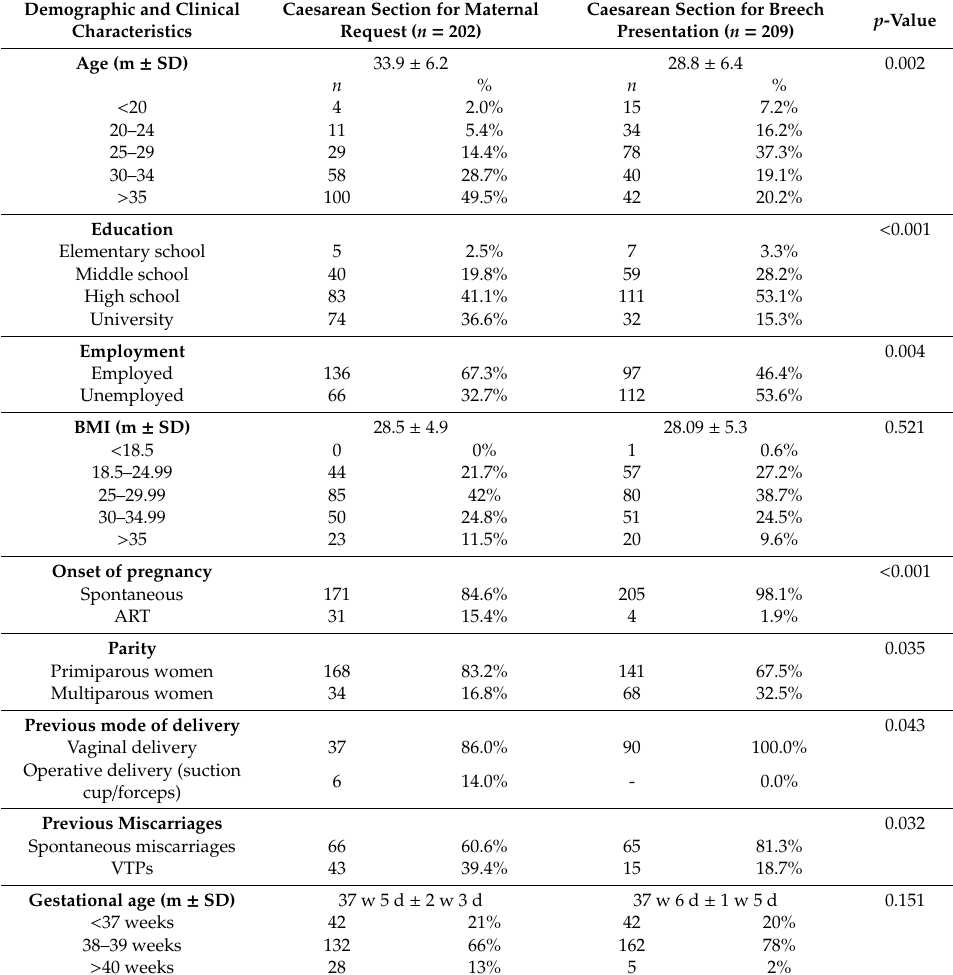
Table 1. Patients’